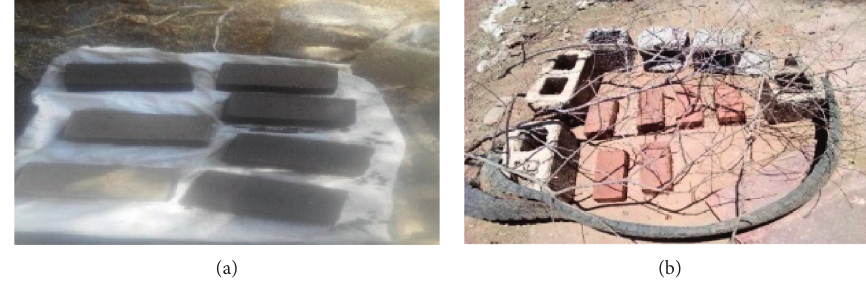
Figure 5: Air drying of the produced brick.